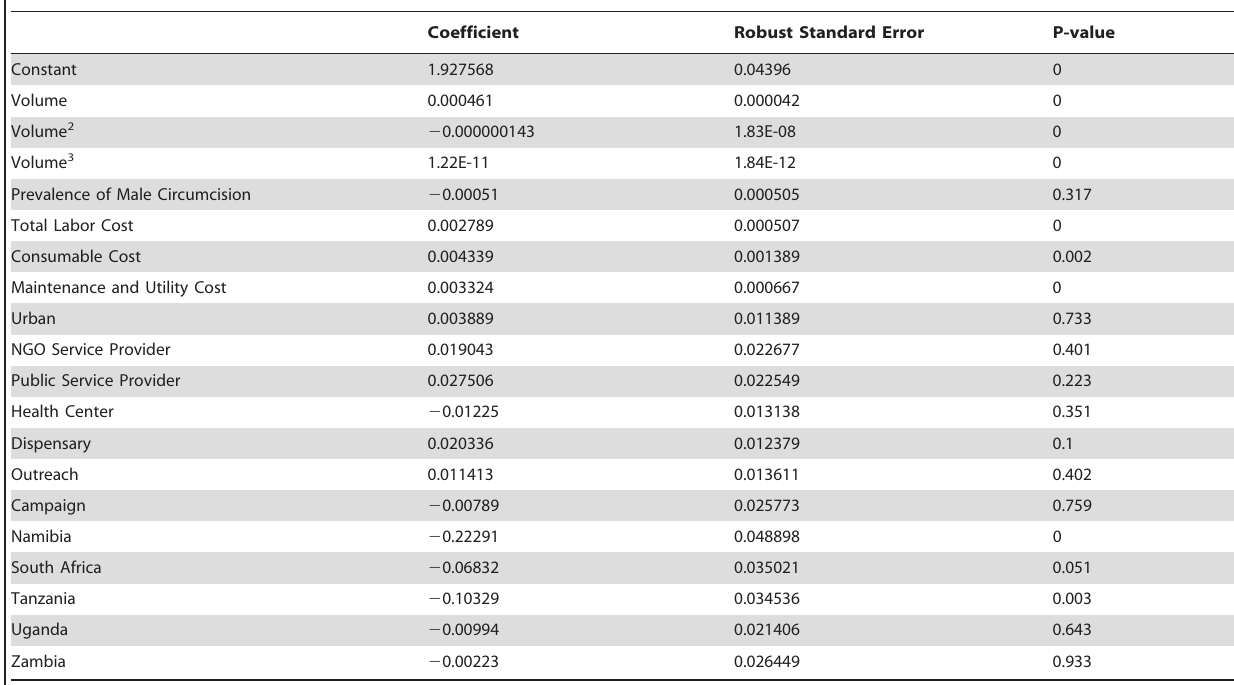
Table 3. Cost function